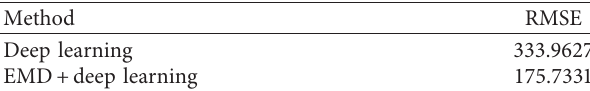
Table 3: RMSE for real data and predicted results for the two methods.